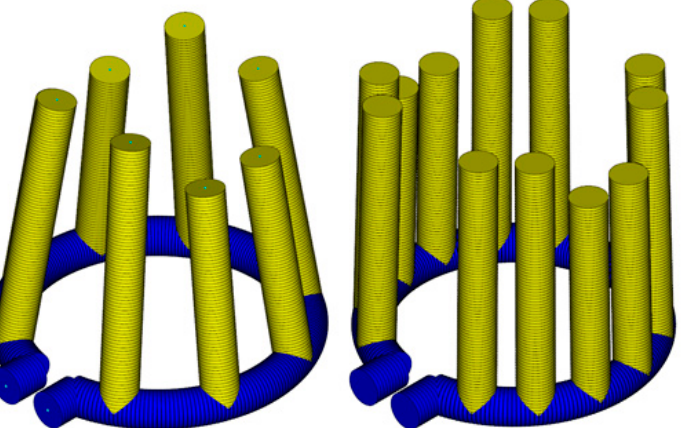
Figure 11. Initial configuration ( left ) and optimized configuration ( right ) of the conventional cooling system.